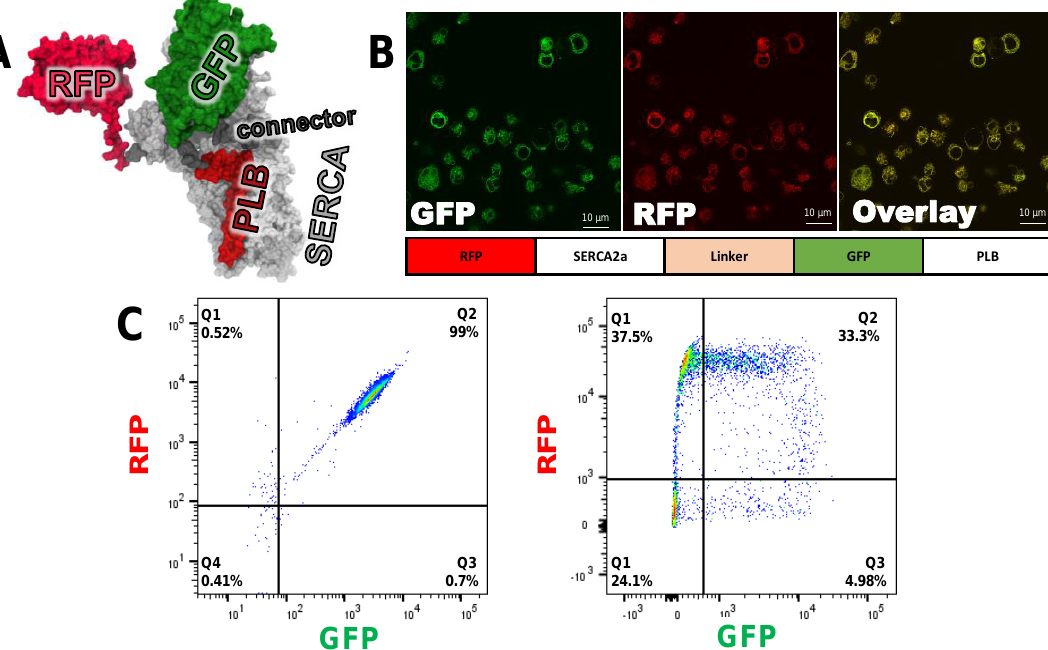
Figure 2. FRET biosensor engineering and characterization ( A ) Molecular model of concatenated sarcoplasmic reticulum Ca-pump (SERCA2a)- phospholamban (PLB) biosensor, based on crystal structures for SERCA2a-PLB (4KYT) [29], red fluorescent proteins (RFP) (3M22) [30], and GFP 1GFL) [31]. Modeling was done with Discovery Studio Visualizer (BIOVIA, San Diego, CA, USA). ( B ) Confocal microscopy of HEK293-6E suspension stable clone expressing the fusion biosensor at the ER membrane. ( C ) Representative flow cytometry of the stable fusion cell line expressing GFP and RFP at a 1:1 ratio, as shown by the 2D scatter plot (left), transient co-transfection of SERCA2a and PLB (right). The percentages of cells with GFP and/or RFP are indicated in each quadrant.